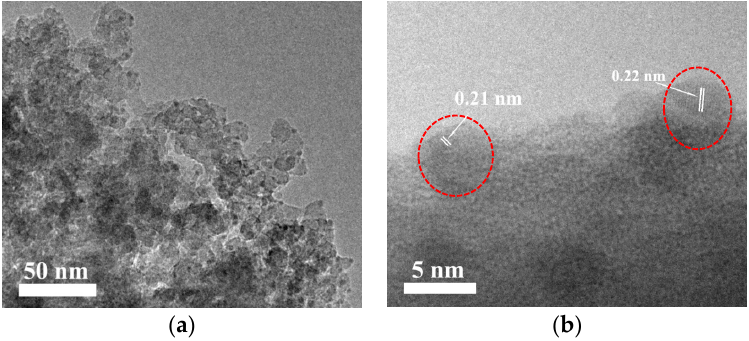
Figure 3. TEM images of the Cu/HZSM-5-M sample ( a ) in a low-magnification and ( b ) in a high-magnification (The metal particles in Figure 3b were surrounded by red circle).